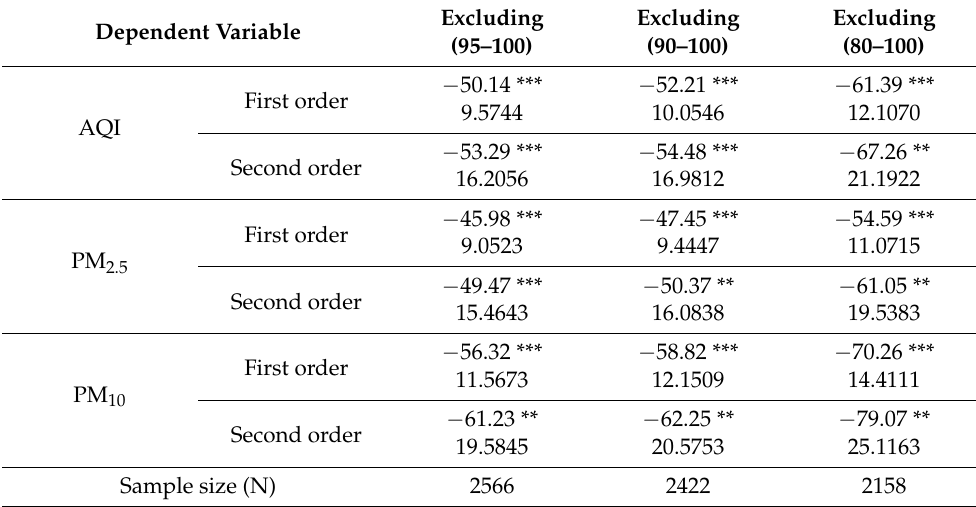
Table 11. Estimated results after removing potentially falsified